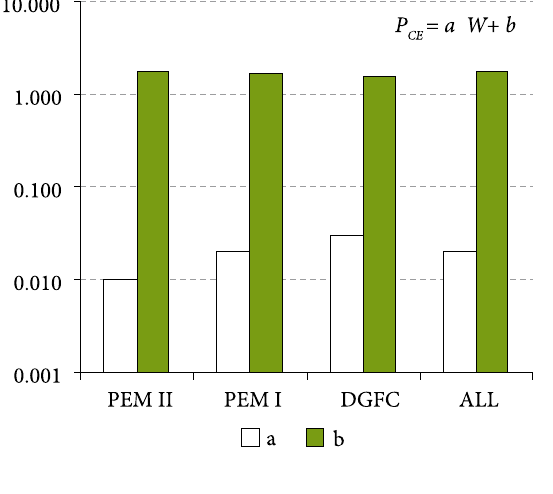
Fig. 11. P CE vs. G mbcor : coefficients